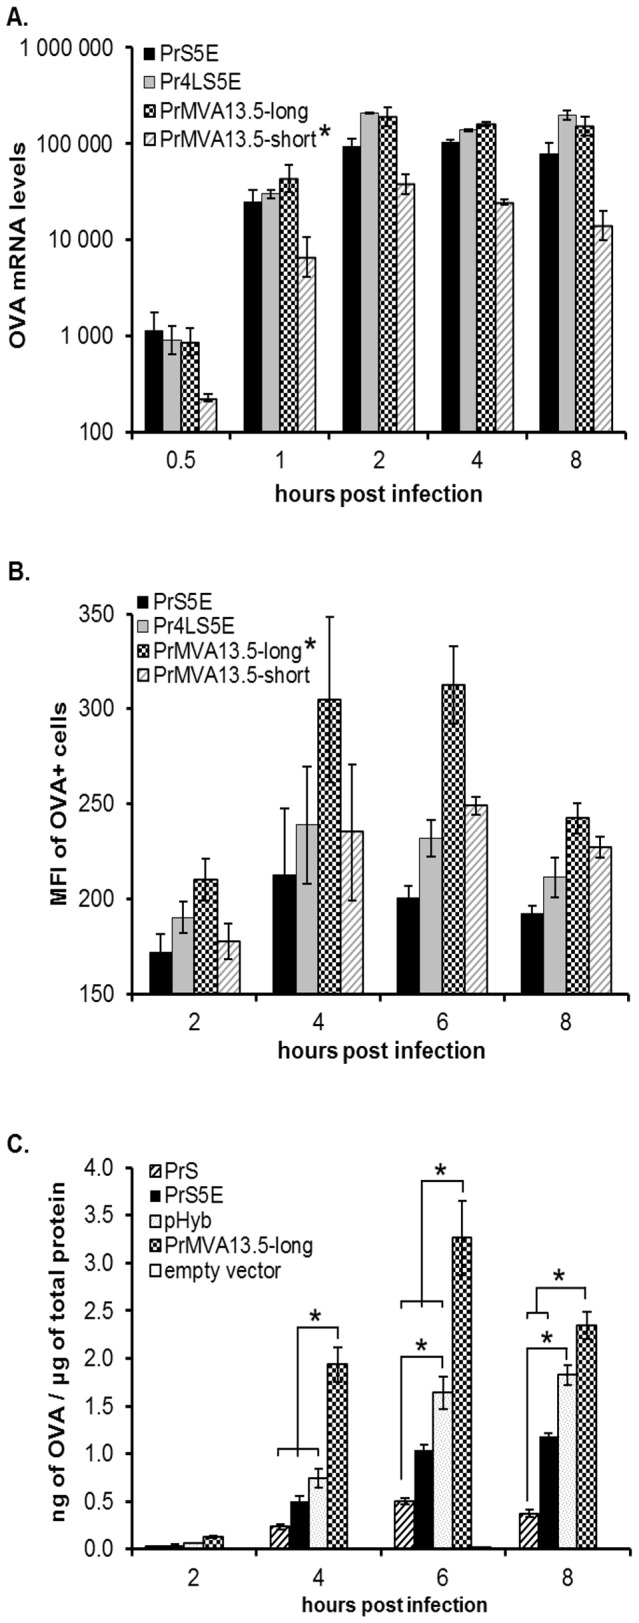
Expression kinetics of the novel MVA13.5L promoter constructs.The kinetics and strength of the PrMVA13.5 promoter constructs were compared to the two novel synthetic hybrid promoters (PrS5E and Pr4LS5E). (A) Cells were collected at 0.5, 1, 2, 4 and 8 hours post infection (p.i.). Total RNA was reverse transcribed and OVA cDNA was detected by qPCR. The fold OVA mRNA levels relative to wildtype MVA were determined using the delta-delta CT method. The average of two independent qPCR runs is shown. Error bars represent ± standard error of the mean (SEM) values. *, indicates the promoter was significantly different when compared to all other promoters (p < 0.0002). (B) Infected cells were harvested at 2, 4, 6 and 8 hours p.i., stained intra-cellularly for OVA protein and analysed by flow cytometry. OVA positive (OVA+) cells were gated and the median fluorescence intensity (MFI) of these cells calculated. For each virus group, three wells were infected using independent virus dilutions. The average MFIs of samples with values above the background obtained from empty vector infected samples (MFI = 150) are shown. Error bars represent ± SEM values. *, indicates the promoter was significantly different when compared to all other promoters (p < 0.02). (C) Infected MDBK cells were lysed at 2, 4, 6 and 8 hours p.i. All samples were standardized to a total protein concentration of 0.1µg/µL and then used for the determination of OVA protein by ELISA. Values shown for each group are the average of three samples infected with independent virus dilutions, processed independently and assayed in duplicate. Values are reported as nanograms (ng) of OVA per µg of total lysate. Error bars represent ± SEM values. *, denotes a significant difference (p < 0.006) between the indicated promoters.